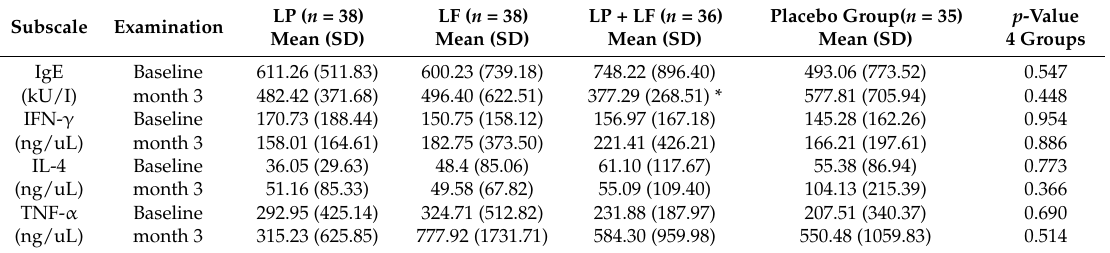
Table 4. Immune biomarker levels at baseline and subsequent changes ( N = 147).